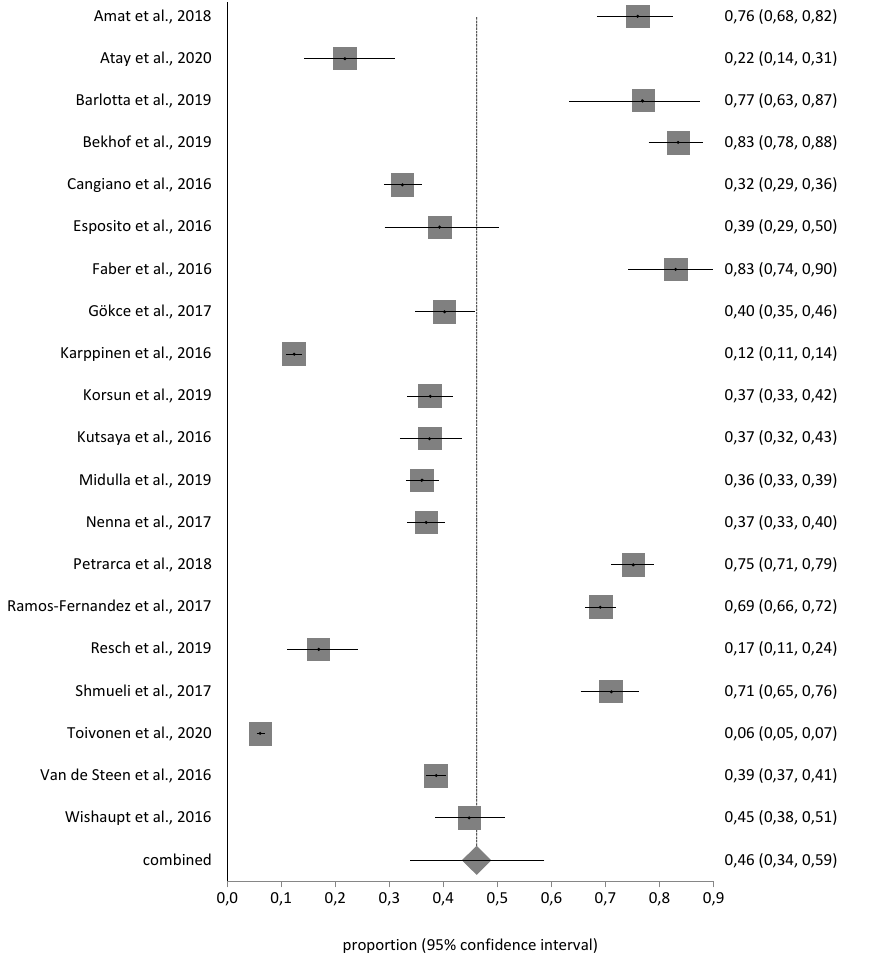
Figure 2. Forest plot of RSV prevalence.